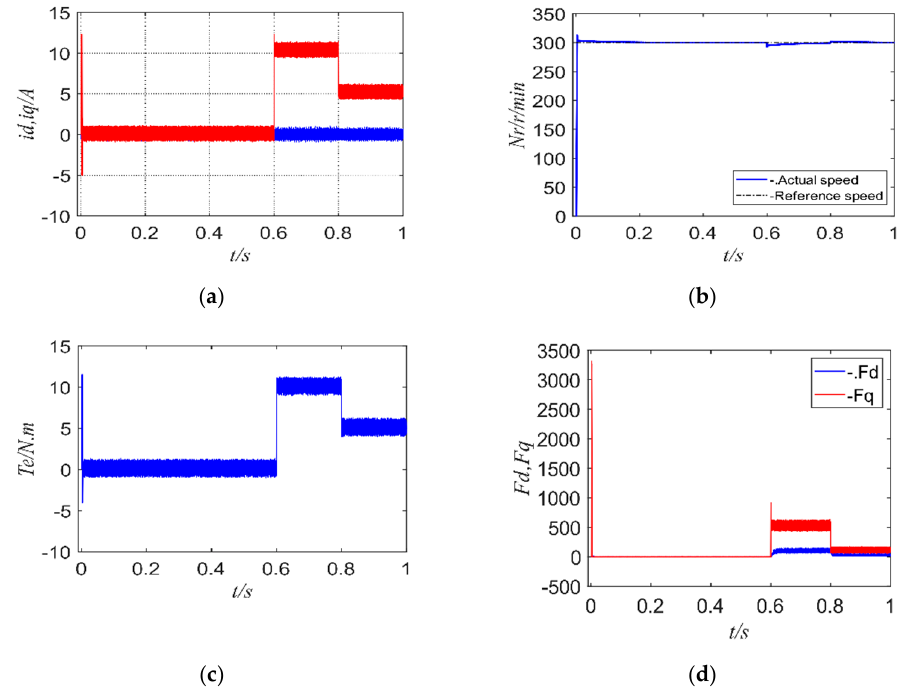
Figure 17. FCS-MFPCC simulation results under parameter perturbation when the sampling period is 50 us: ( a ) dq -axis current of FCS-MFPCC; ( b ) speed of FCS-MFPCC; ( c ) torque of FCS-MFPCC; ( d ) observed values of the unknown quantities Fd and Fq under parameter perturbation.